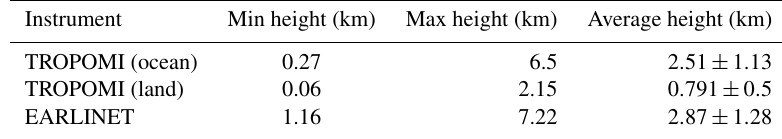
Table 4. Layer height retrievals (min, max, and average) of the EARLINET and TROPOMI ALH co-locations. Instrument Min height (km) Max height (km) Average height (km) TROPOMI (ocean) 0.27 TROPOMI (land)